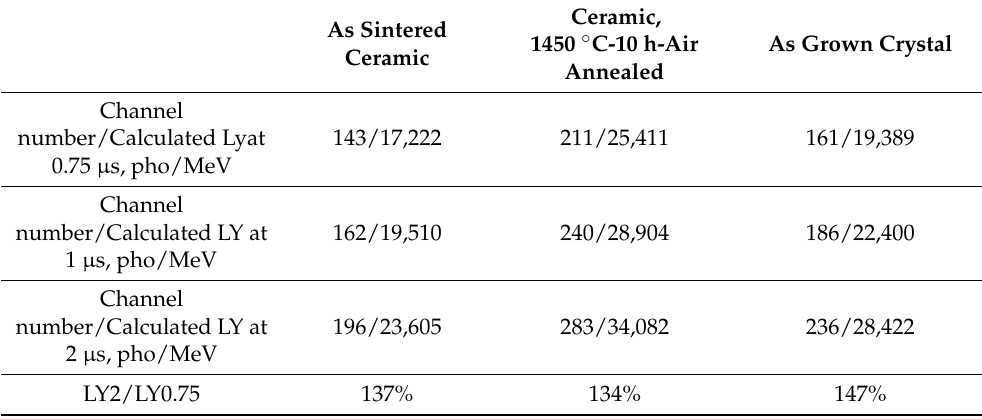
Table 2. Channel number and calculated LY values (pho/MeV) using a standard Ce:GGAG crystal (LY 58,000 pho/MeV, size: 27 × 15 × 2.37 mm 3 ) with the corresponding peak at channel number 481.6, FWHM 33.60, and E.R 6.98% as reference. As Sintered Ceramic